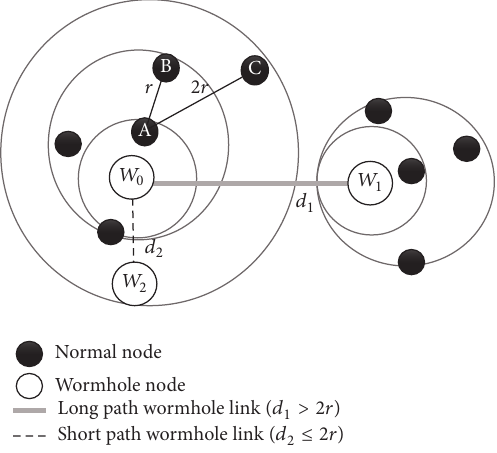
Figure 2: Illustration of proposed